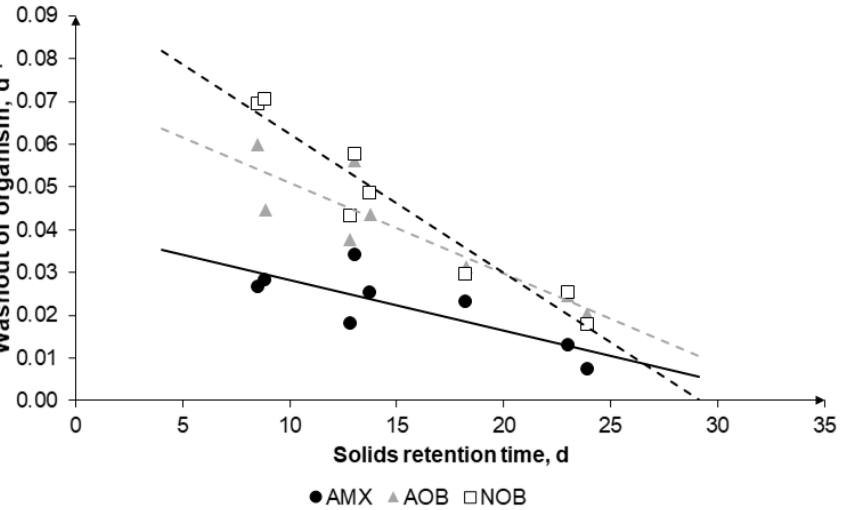
Figure 5. Dilution rate by anammox (AMX) (black circles with black trendline), ammonia-oxidizing bacteria (AOB) (grey triangle with grey line), nitrite-oxidizing bacteria (NOB) (white cubes with black dashed line), versus solids retention time of the suspended sludge continuous stirred tank reactor with hydrocyclone. The R-square was 0.6, 0.8, and 0.9 for AMX, AOB, and NOB, respectively.